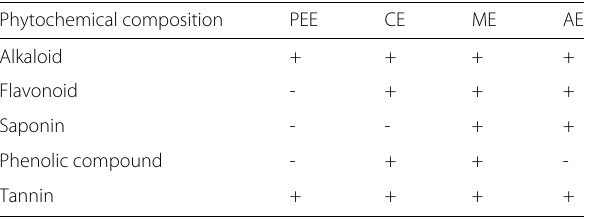
Table 1 Qualitative chemical analysis of different extracts of C. pallida stem